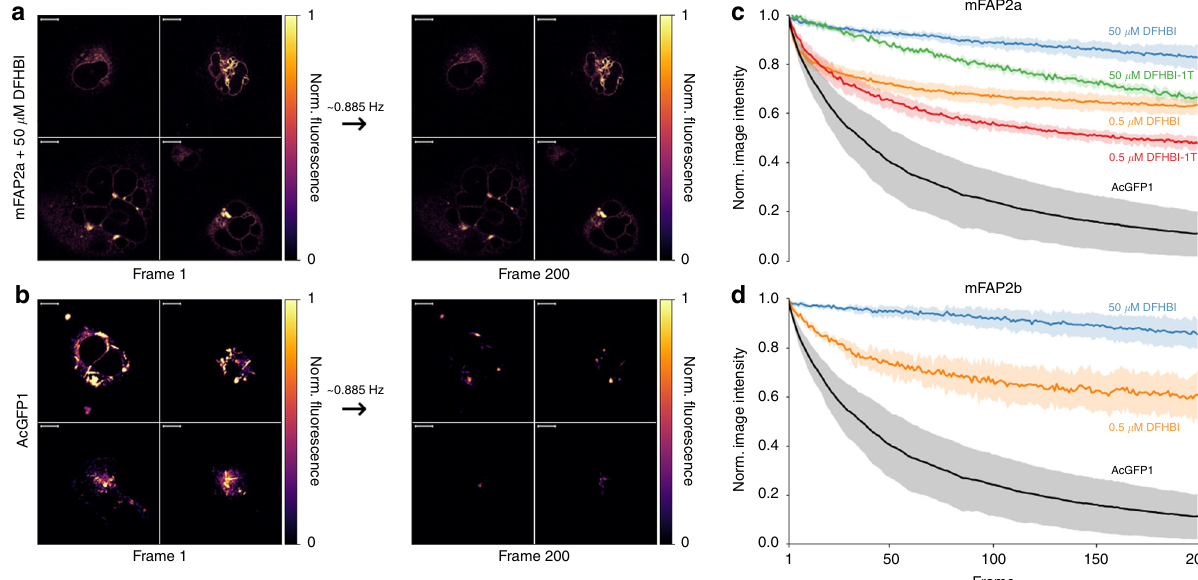
Fig. 2 Photostability of mFAPs compared to AcGFP1. a , b Normalized fl uorescence intensity images for four regions of interest (ROIs) acquired under continuous wave imaging at ~0.885 Hz (1.13 s frame − 1 ) shown for frame 1 (left) and frame 200 (right) of fi xed COS-7 cells expressing endoplasmic reticulum-targeted a mFAP2a labeled with 50.0 µ M DFHBI compared to b AcGFP1. Scale bars represent 10 microns. c , d Means (lines) and s.d. of the means (shading) of the normalized summed pixel intensities of four ROIs ( n = 4) under continuous wave imaging (~0.885 Hz) for c mFAP2a labeled with 50.0 µ M DFHBI (~330-fold above K d ) (blue) , 500 nM DFHBI (~3.3-fold above K d ) (orange) , 50.0 µ M DFHBI-1T (~8.6-fold above K d ) (green) , or 500 nM DFHBI-1T (~12-fold below K d ) (red) compared to AcGFP1 (black) , and d mFAP2b labeled at 50.0 µ M DFHBI (~28-fold above K d ) (blue) or 500 nM DFHBI (~3.6-fold below K d ) (orange) compared to AcGFP1 (black) . Source data is available for Fig. Ca 2 + -responsive mFAPs exhibit over 500-fold differences in af fi nity for Ca 2 + (Supplementary Table 2), enabling the choice of a sensor with optimal fl uorescence dynamic range in the anticipated Ca 2 + concentration range under study.